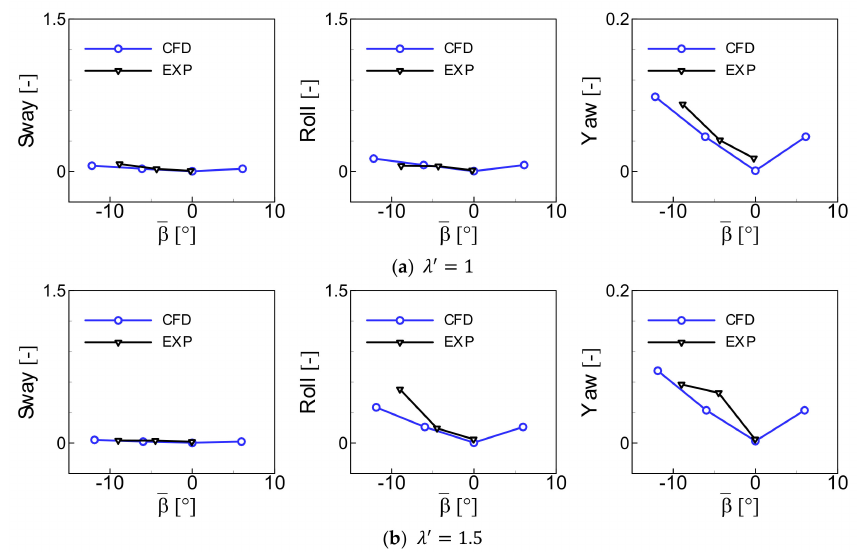
Figure 11. RAOs of sway, roll and yaw versus mean the oblique angle in head waves.